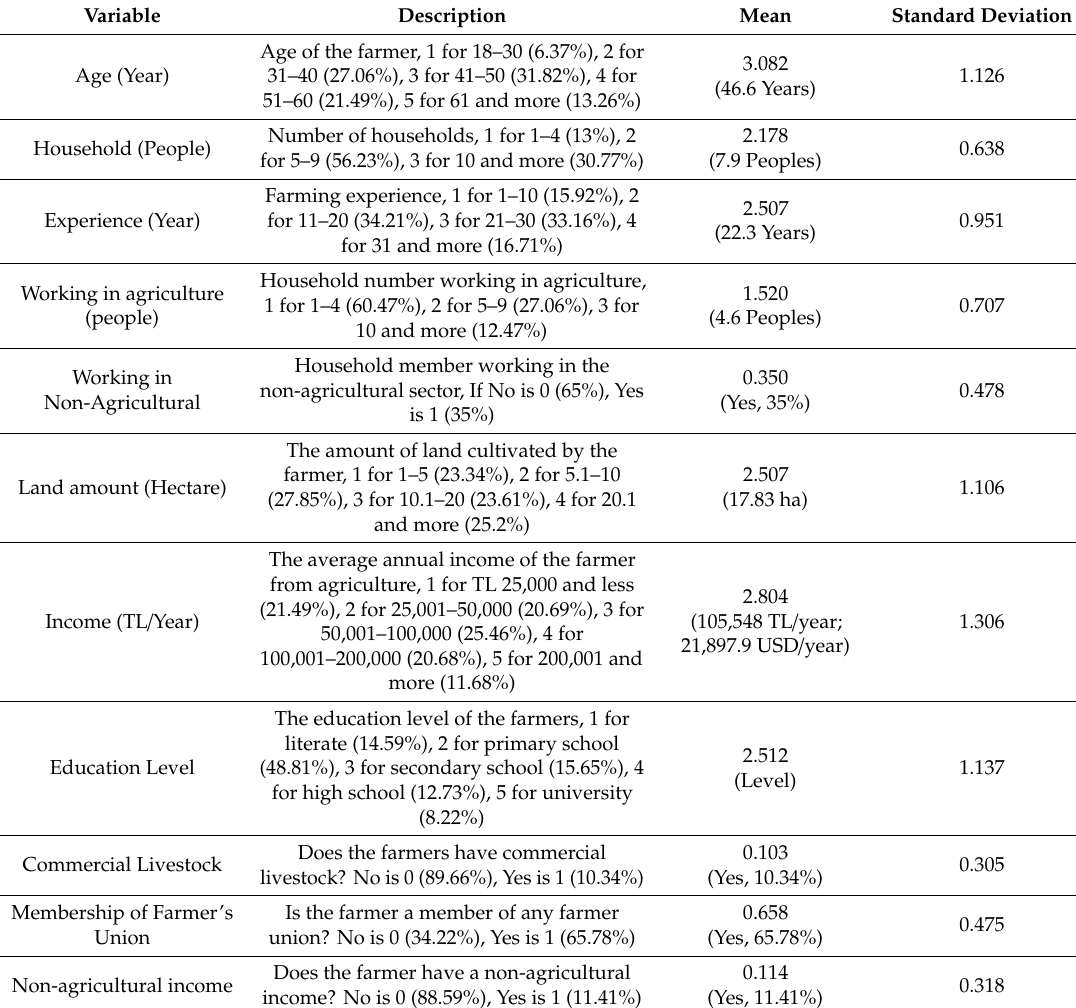
Table 1. The descriptive statistics of the surveyed